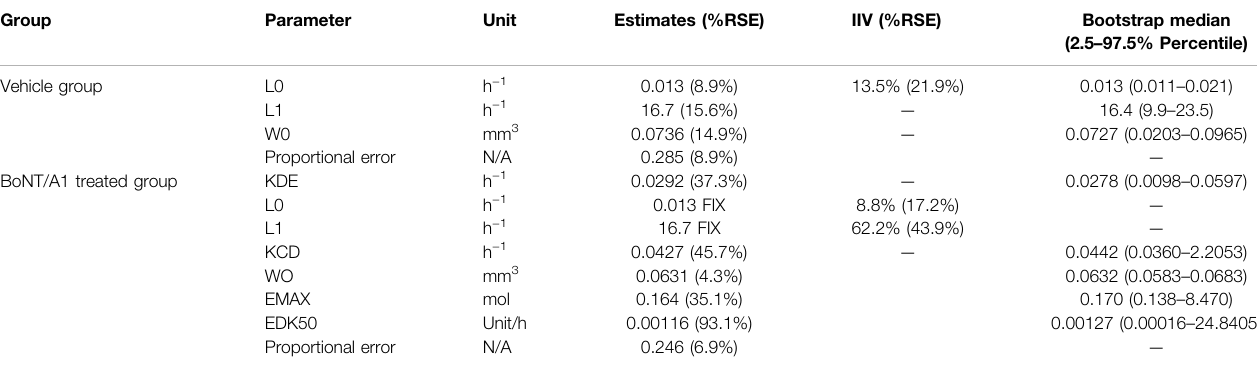
TABLE 3 | Parameters estimated via fi nal K-PD model and bootstrap validation.